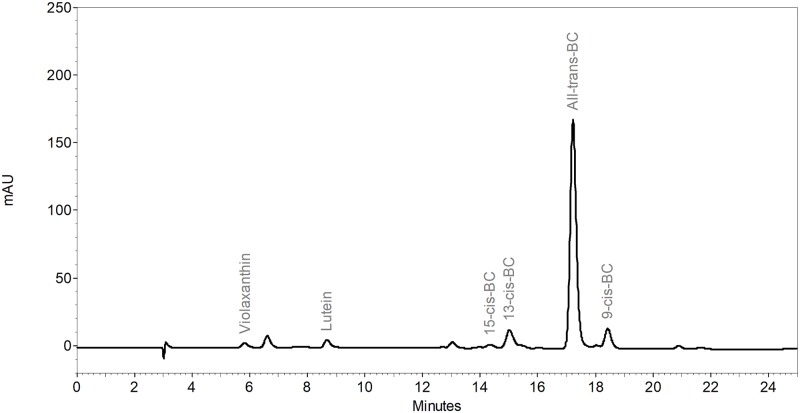
HPLC chromatogram for cassava storage roots (detection at 450 nm).HPLC conditions are described in the text.